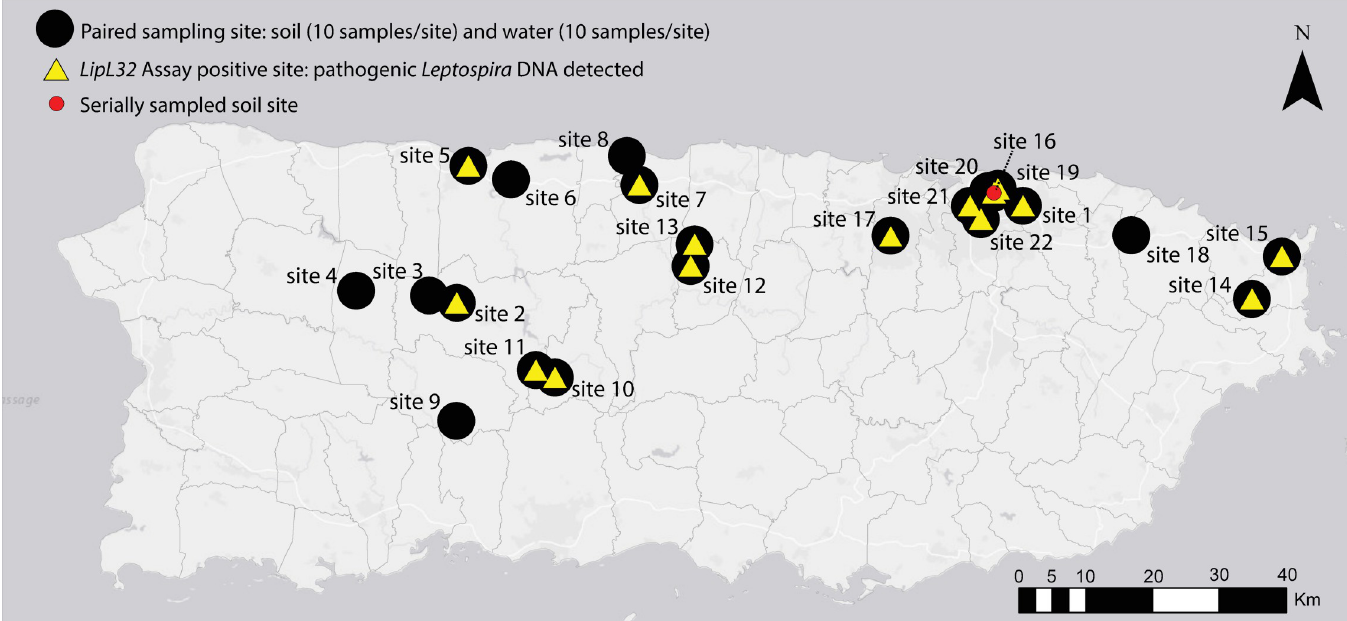
Fig 1. Map of Puerto Rico indicating sites where environmental samples were collected for the detection of pathogenic Leptospira spp. DNA from 2018–2020. Black dots represent paired water and soil sites (n = 22); 20 samples were collected from each site (10 soil and 10 water). Yellow triangles indicate sites where pathogenic Leptospira DNA was detected (15/22 sites). One site in San Juan (site 16, red circle) was serially sampled three times over a 14-month period to assess persistence of pathogenic Leptospira in soil. This map was created using ArcGIS software by Esri. ArcGIS and ArcMap are the intellectual property of Esri and are used herein